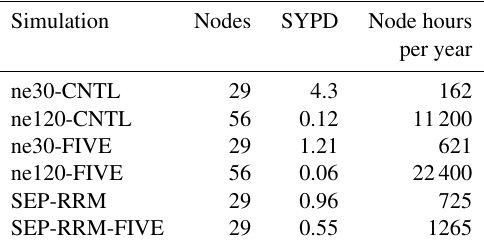
Table 3. The computational expense of each simulation as run on Livermore Computing (LC) machines. SYPD stands for simulated years per day. Node hours are computed as nodes used multiplied by the number of hours required to simulate 1